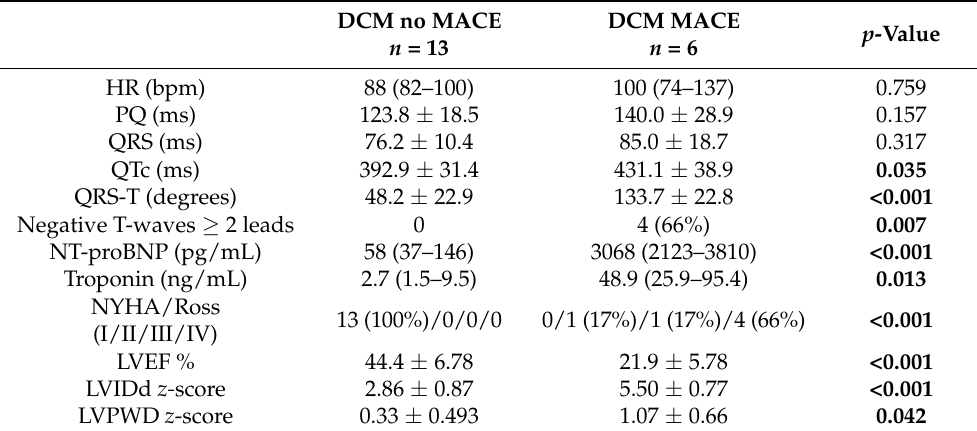
Table 3. Parameters associated with adverse outcomes in patients with DCM.